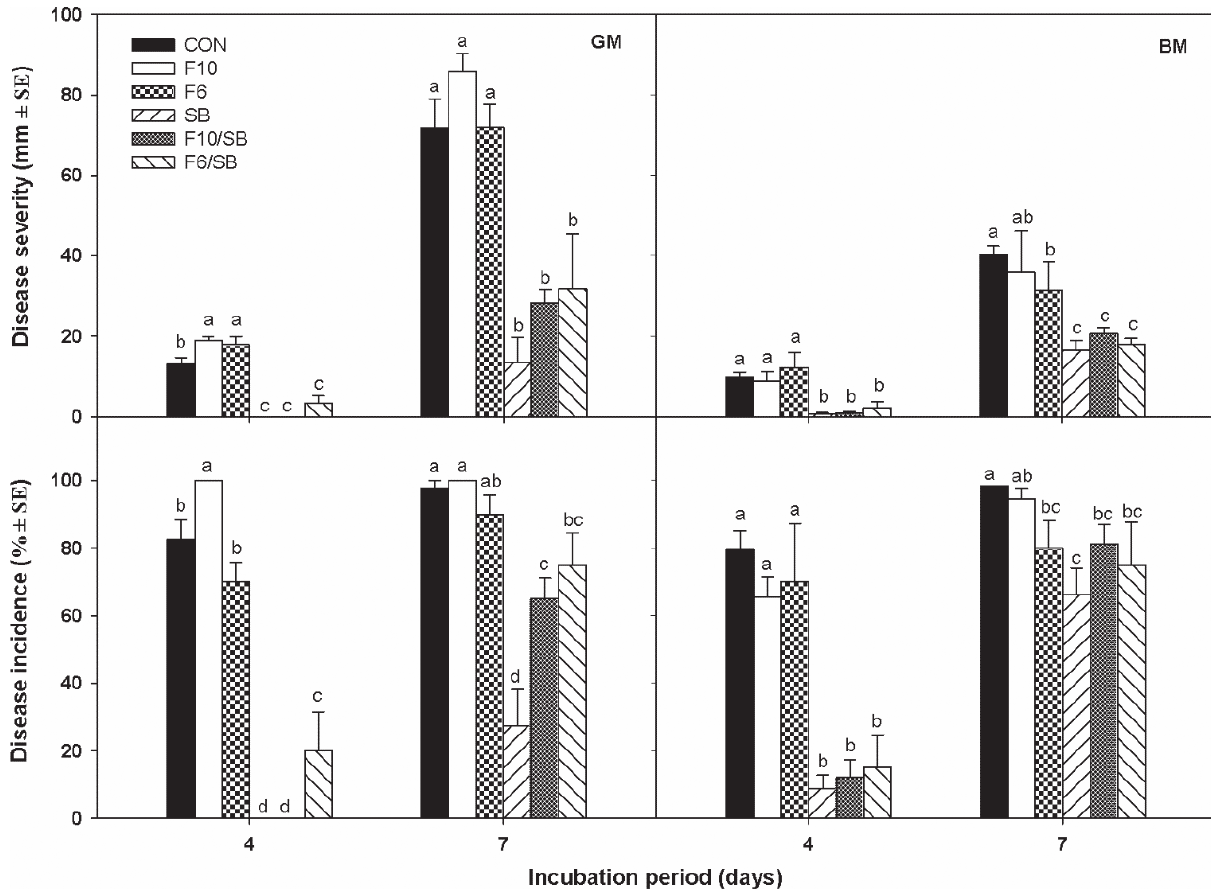
Figure 1. Mean severity and incidence of green mould (GM) or blue mould (BM) on ‘Orri’ mandarins artificially inoculated, respectively, with Penicillium digitatum or P. italicum , then coated 24 h later and incubated for 4 and 7 d at 20°C and 90% RH. Treatments applied were: control (CON) = uncoated (immersion in water), F10 coating, F6 coating, 2% sodium benzoate (SB) aqueous solution (w/v), F10/SB coat- ing, or F6/SB coating (see Table 2 for coating composition). For each disease and incubation period, columns accompanied by different let- ters are significantly different (Fisher’s protected LSD test; P < 0.05). Vertical lines above columns indicate standard errors. Incidence values were arcsine-transformed before statistical analyses. Non-transformed means are